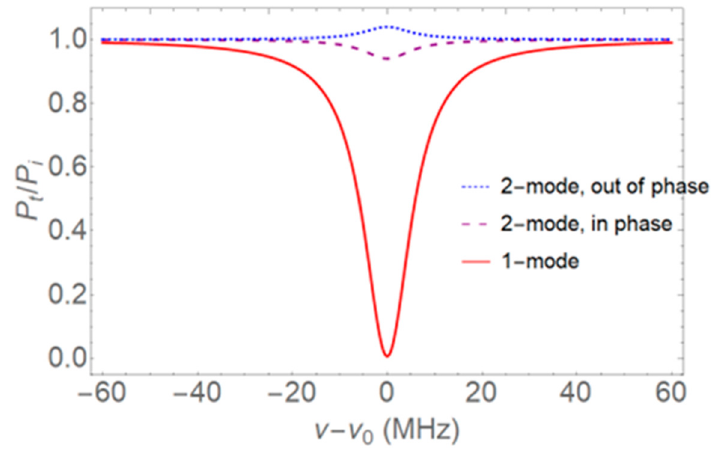
Figure 2. Conditions leading to large sensitivity enhancement. Relative throughput power R = P t / P i from a fiber-coupled microresonator WGM is plotted as a function of detuning from WGM resonance. With two incident fiber modes, a shallow dip results if they are in phase (purple dashed curve, R 00 = 0.940) and a small peak appears if they are out of phase (blue dotted curve, R 0 π = 1.040). With one incident fiber mode, the coupling is near critical (red solid curve, M = 0.9937).